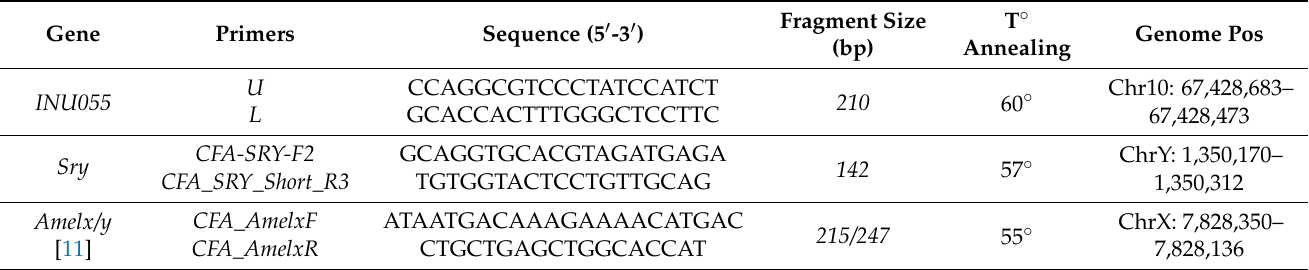
Table 1. Primers and PCR conditions.